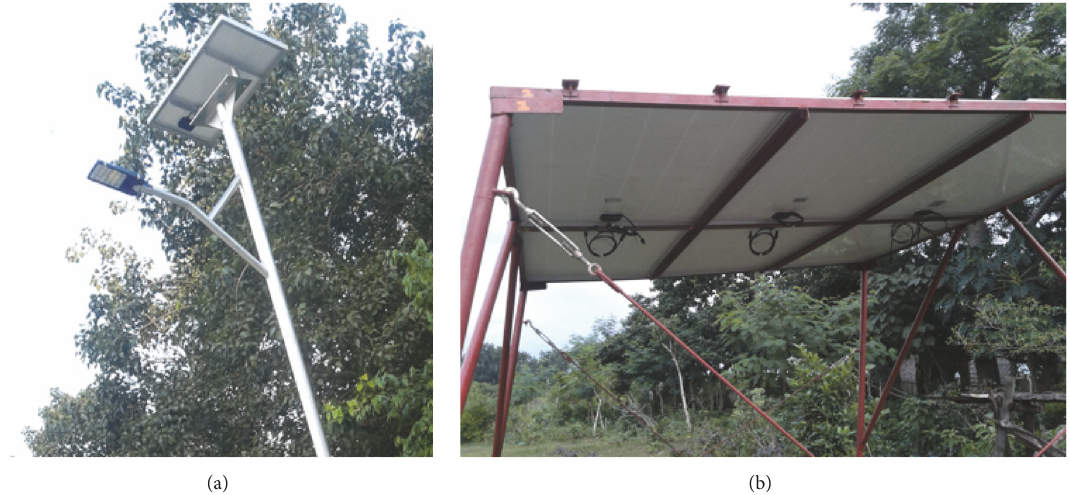
Figure 2: Solar street lamps for (a) farm lighting and (b) the 6-panel PV installation.